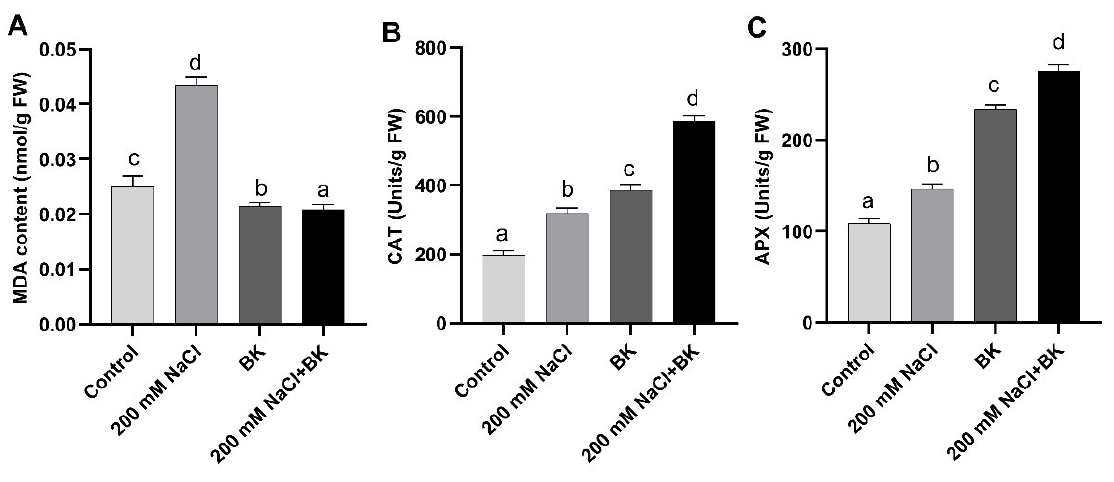
Figure 6. Influence of A. welwitschiae BK on antioxidant potential, ( A ) MDA content, ( B ) Catalase activity, ( C ) Ascorbate peroxidase activity of maize raised under salt stress. Data represent the means and SE of three independent replicates for each treatment. Significant differences ( p ≤ 0.05) are marked with different le tt ers.